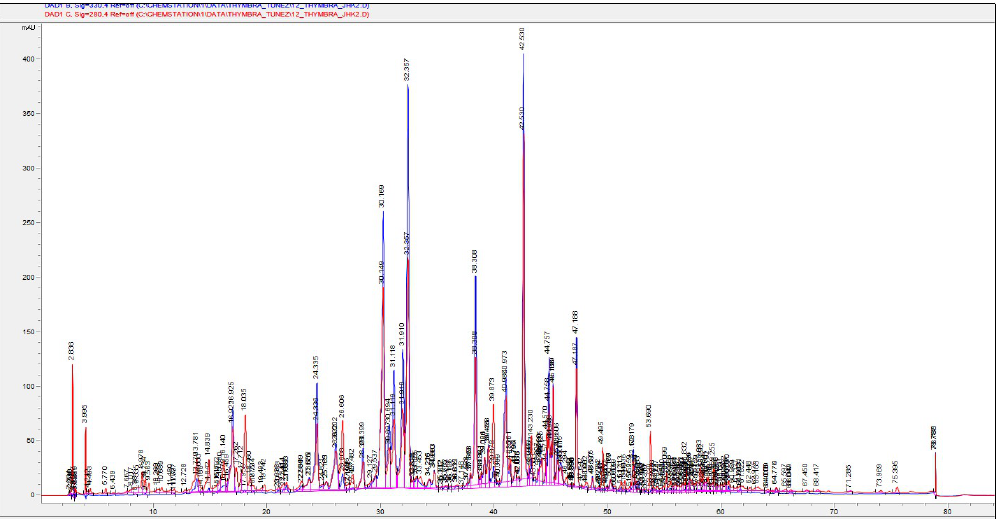
Figure 1. HPLC chromatogram of thyme residue extract at 280 nm and 330 nm with Retention Time. Table 2. HPLC polyphenolic profile of thyme post-distilled